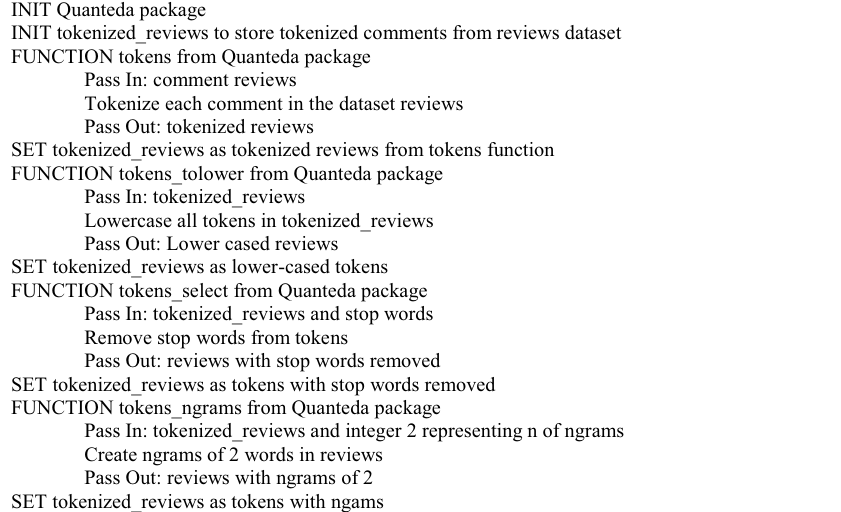
Table 3 Pseudocode to tokenized and pre-process tokens from reviews dataset INIT Quanteda package INIT tokenized_reviews to store tokenized comments from reviews dataset FUNCTION tokens from Quanteda package Pass In: comment